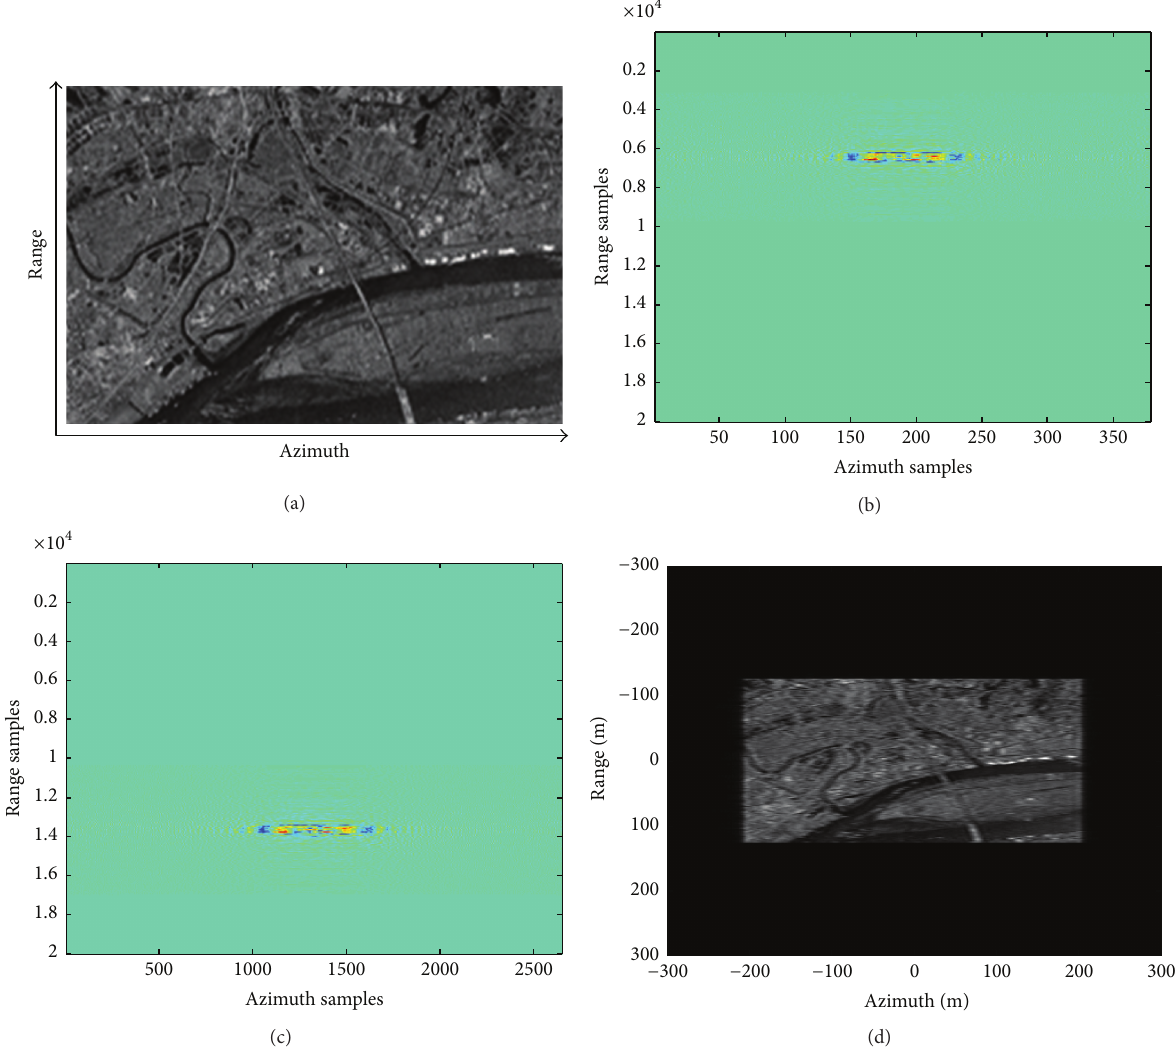
Figure 11: Simulation results of the designed distributed scene. (a) The designed extended scene. (b) Echoes of the imaged scene corresponding to the first subpulse after DBF with null steering. (c) Echoes of the imaged scene corresponding to the second subpulse after DBF with null steering. (d) Two-dimension spectrum of the imaged